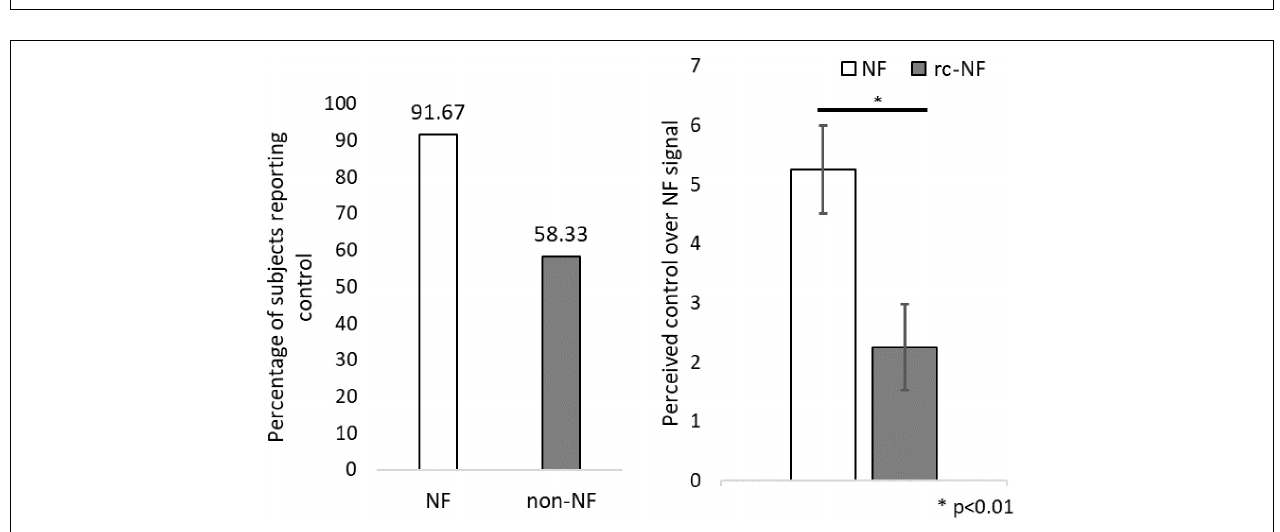
FIGURE 7 | (Left) Participants reporting if they perceived control over the NF modality. (Right) Amount of perceived control over neural regulation. ∗ p < 0.01.